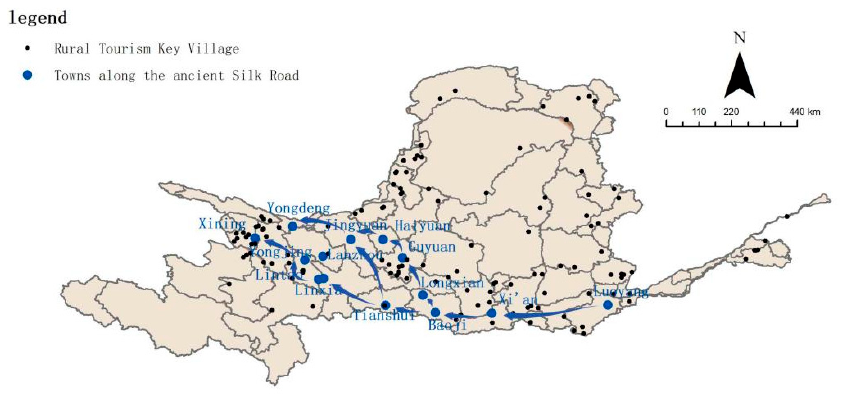
Figure 5. Ancient Silk Road Map of Key Rural Tourism Villages in the Yellow River Basin.